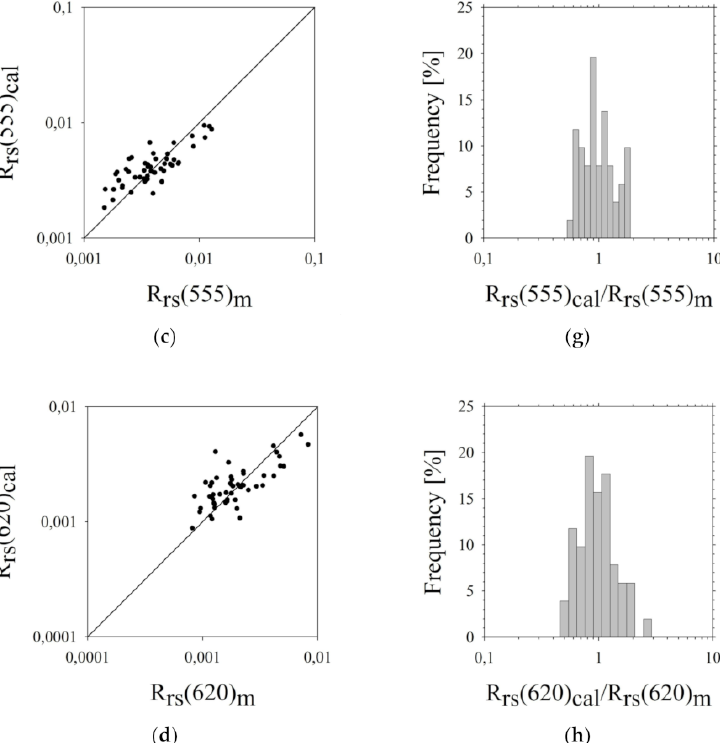
Figure 8. ( a – d ) Comparison of the measured R rs ( λ i ) m and calculated R rs ( λ i ) cal (Equations (43)–(46), Table 3) for four wavelengths ( λ i = 420 nm, 488 nm, 555 nm and 620 nm) in the selected areas of the southern Baltic. The solid line represents the function ( R rs ( λ i ) m = R rs ( λ i ) cal ) ( e – h ). The probability